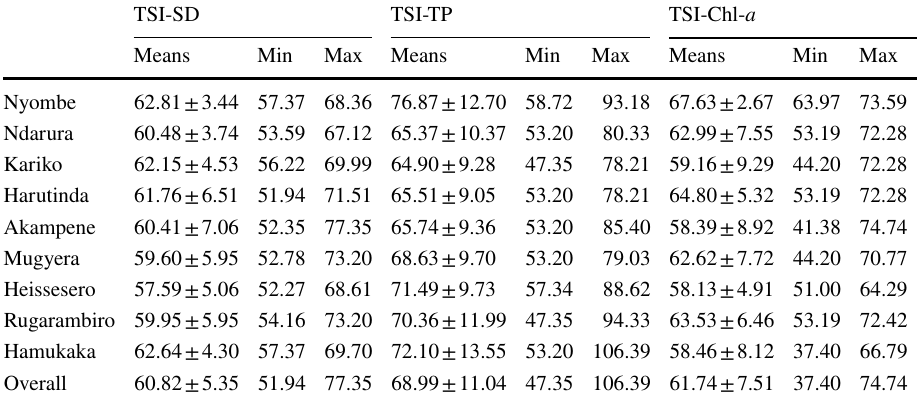
Table 4 Mean ± Std. Dev. of the trophic state indices at different stations ( n = 108)